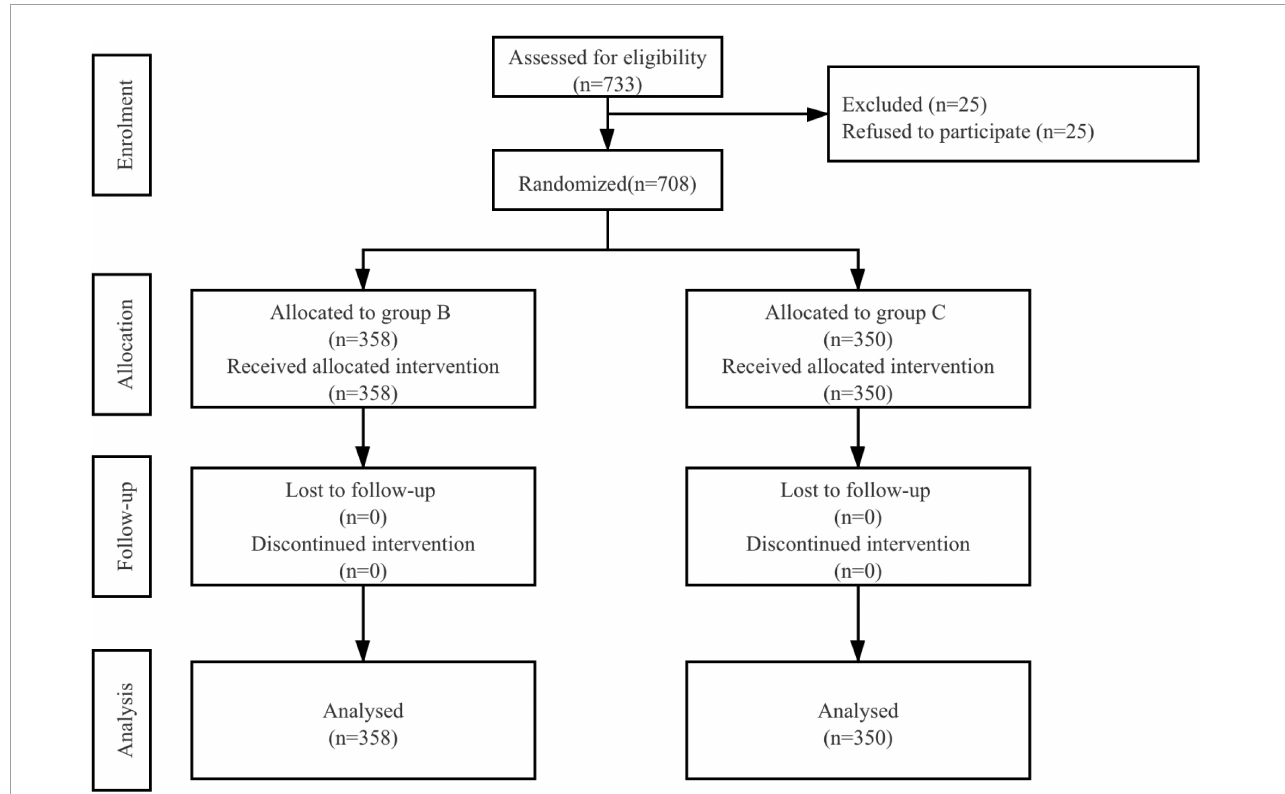
FIGURE1 Patient assignment to study group (randomized) and treatment protocols. B, butorphanol; C, control with normal